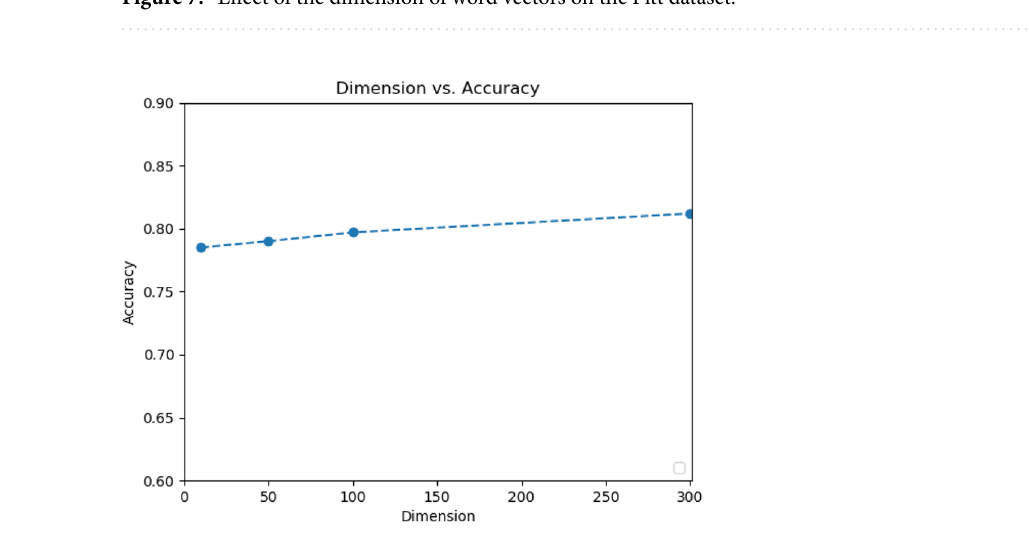
Figure 8. Effect of the dimension of word vectors on the NTUHV